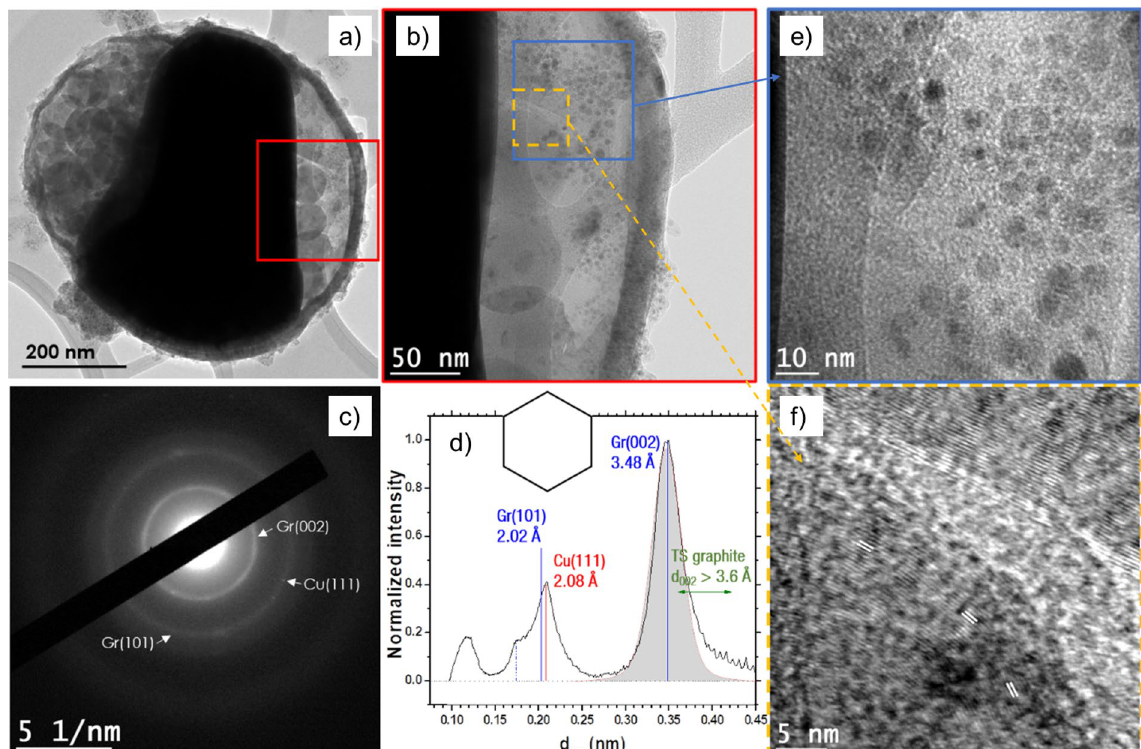
Figure 4. ( a ) High-resolution image of a submicronic particle synthesized by discharges in cyclohexane. ( b ) HRTEM image of the red inset of ( a ), which displays Cu nanoparticles (blue inset, ( e )) and graphite onions (dashed orange inset, ( f )). ( c ) SAED pattern from ( a ) exhibiting Cu and Gr rings. ( d ) A radially integrated profile permits to highlight Cu (111) reflections. The dotted blue line corresponds to the second-order graphite (004)